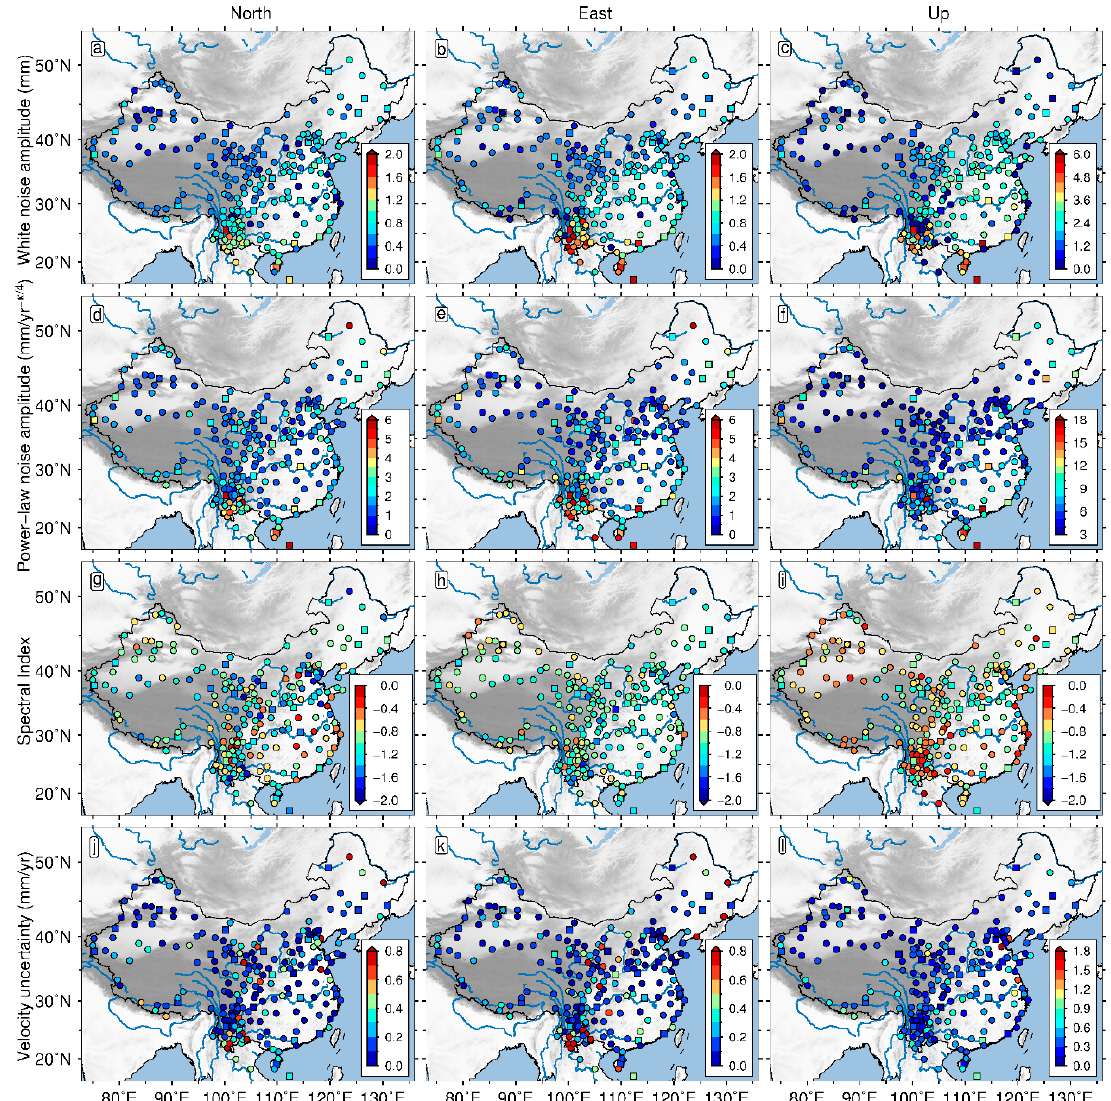
Figure 12. Same as Figure 11, but for the CMC filtered time series.